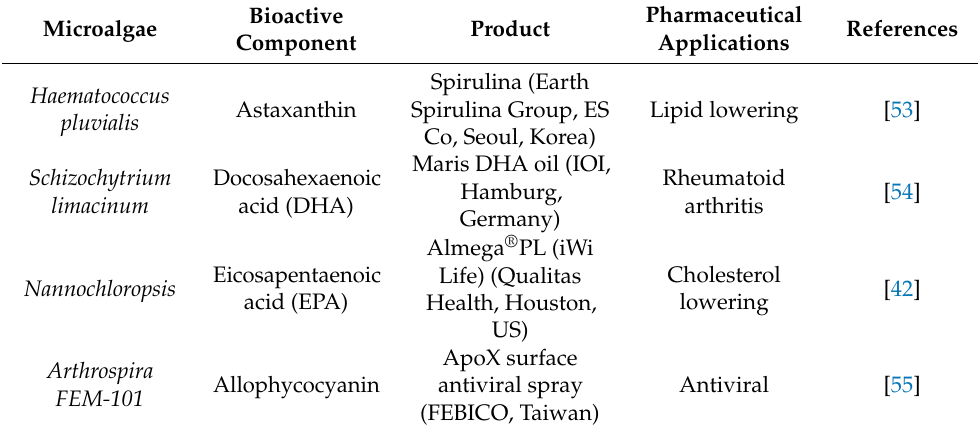
Table 2. Examples of bioactive components from microalgae that are produced on a commercial scale.